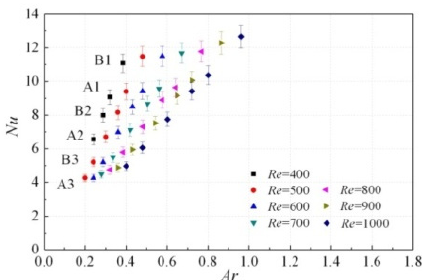
Figure 10. Nusselt number variation with A r , Va = 250.